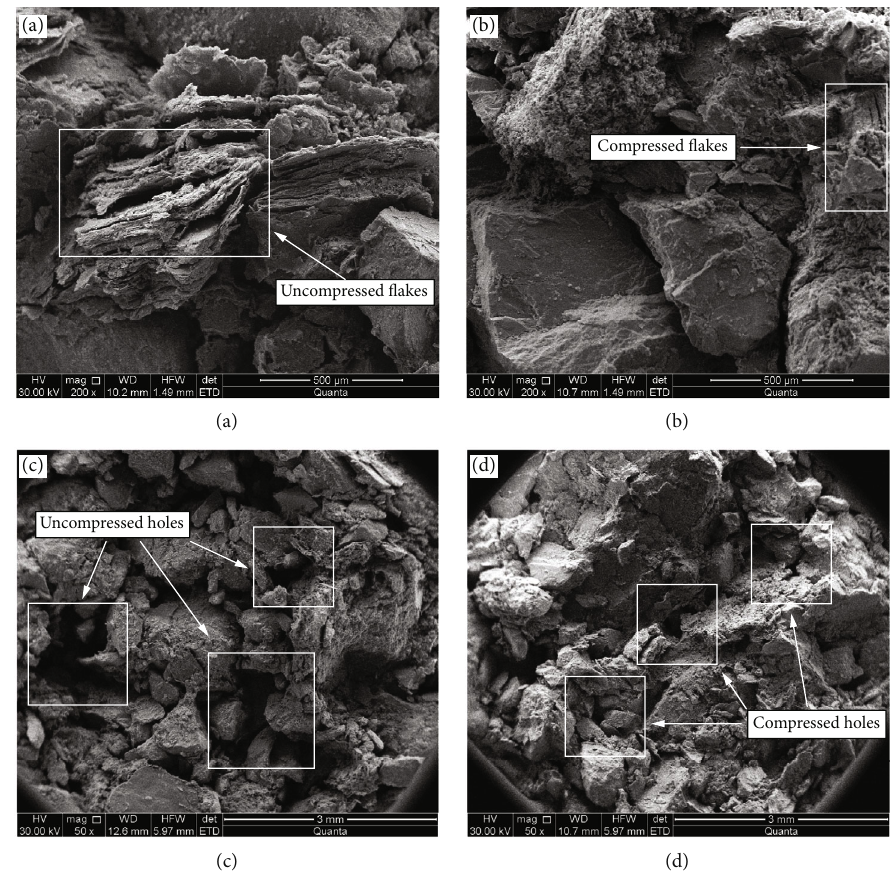
Figure 13: SEM photos of HWG and HWB R3: (a) original state for undisturbed HWG ( magnification = 200 × ); (b) e ff ective consolidation pressure 900kPa for undisturbed HWG ( magnification = 200 × ); (c) the natural state for remolded HWG R3 ( magnification = 50 × ); (d) e ff ective consolidation pressure 900 kPa for remolded HWG R3 ( magnification = 50 × ). (Figures 13(a) and 13(b) from Wang et al. [26] Figure 13).